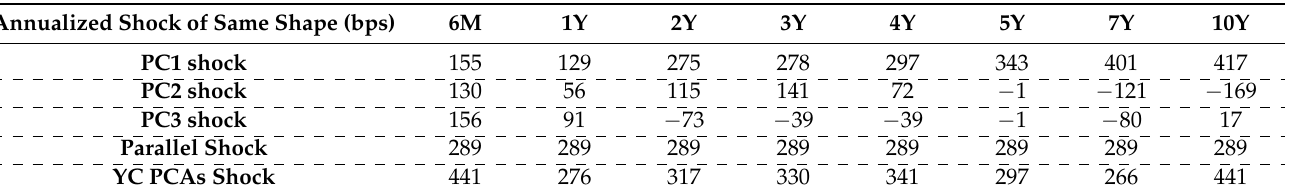
Table A3. Two-standard-deviation PCA annualized yield curve shocks and corresponding explana- tory powers on 25 March 2022.